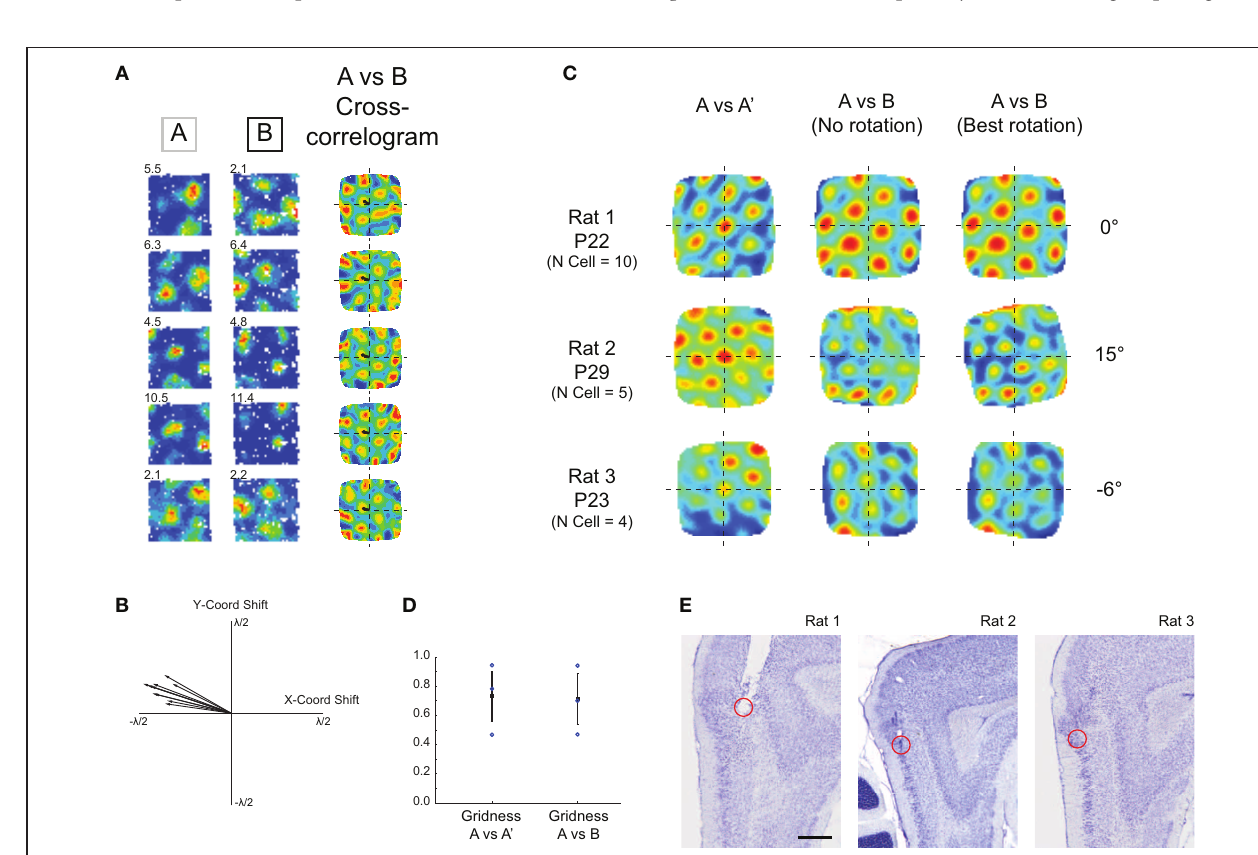
FIGURE 2 | Grid cells simultaneously recorded in young rats maintain their relative spatial structure in different environments. (A) Example cells recorded at P22 in two different environments. Left-hand column: rate map for cell in Env A, middle column: rate map for cell in Env B, right-hand column: cross-correlogram for Env A rate map vs. Env B rate map. Note that all cross-correlograms show the same hexagonal symmetry and the same phase offset (small black arrow), indicating that all cells have shifted their firing fields coherently between Env A and Env B. (B) Phase offset vectors for all grid cells recorded in experiment shown in (A) are clustered together. (C) Population vector cross-correlograms for three simultaneously recorded grid cell ensembles. Left-column: population vector cross-correlogram for two different trials in Env A. Hexagonal structure shows repeatable grid firing